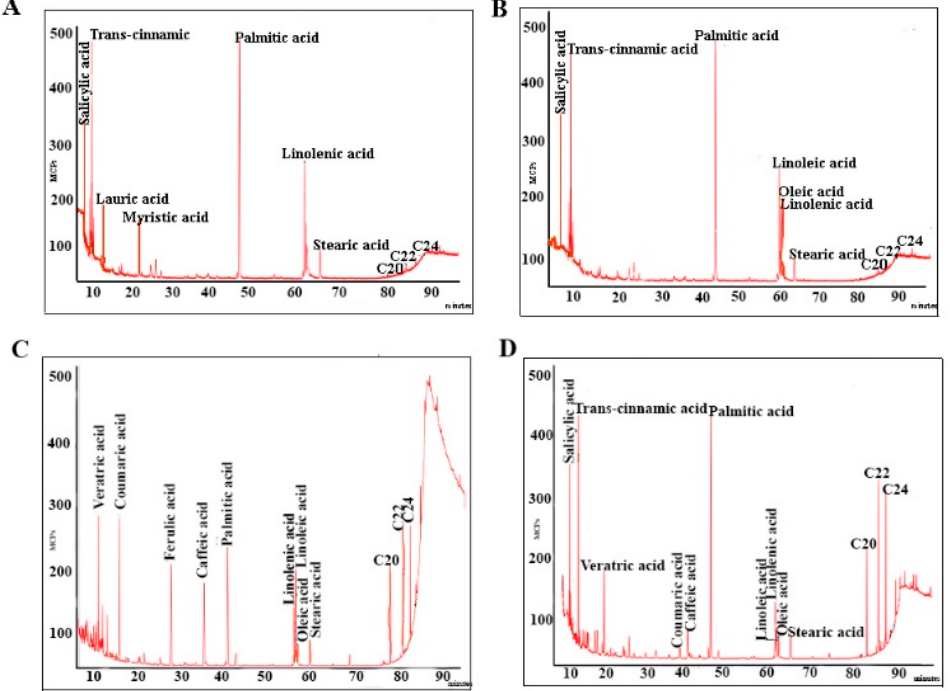
Figure 3. Chromatograms of the samples studied: phenolic acids and fatty acids in S. perennis and A. macrostachyum ( A ) S. perennis sample 12. ( B ) S. perennis samples 13 and 14. ( C ) A. macrostachyum samples 15 and 17. ( D ) A. macrostachyum samples 16 and 18–20. Sample 1 of S. alpini presented veratric acid and trans-cinnamic acid with 39% of relative content, while coumaric and caffeic acid accounted for around 10%. For S.